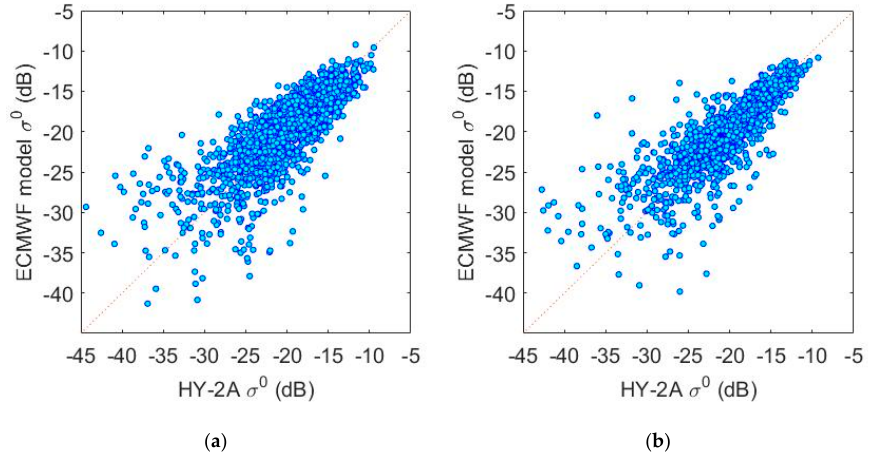
Figure 3. Scatter plot of measure σ 0 and model σ 0 paired data without rainfall. ( a ) for HH polarization; ( b ) for VV polarization. The dashed line in this figure is the diagonal line. Table 2. Dependence of σ 0 residual (HY-2A-ECMWF) on the ECMWF wind speed statistical analysis.